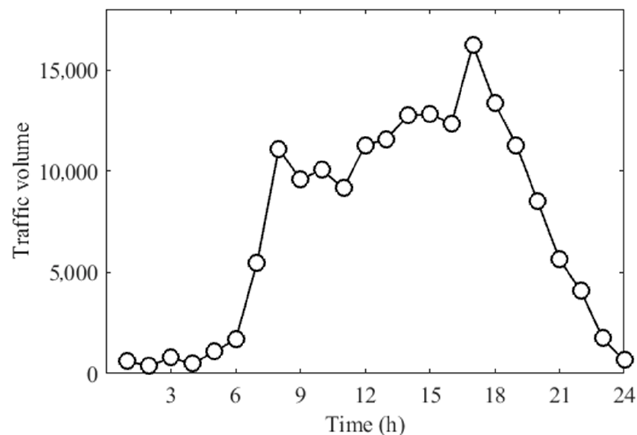
Figure 6. Traffic volume of an induction loop.